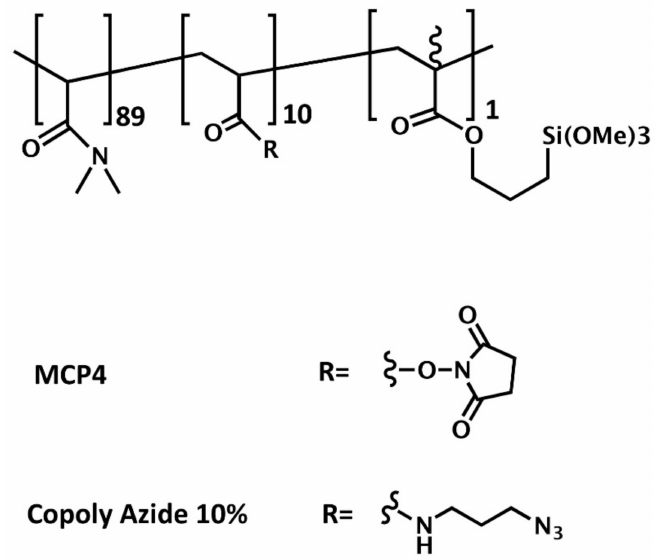
Figure 1. Structure of MCP-4 and Copoly Azide 10% copolymers. Both copolymers have a backbone of N,N -dimetheylacrilamide, but while MPC-4 contains N -acryloyloxysuccinimide as functional groups, which allows nucleophile substitution with amines, Copoly Azide 10% bears azide moieties for click chemistry reactions with alkyne or DBCO